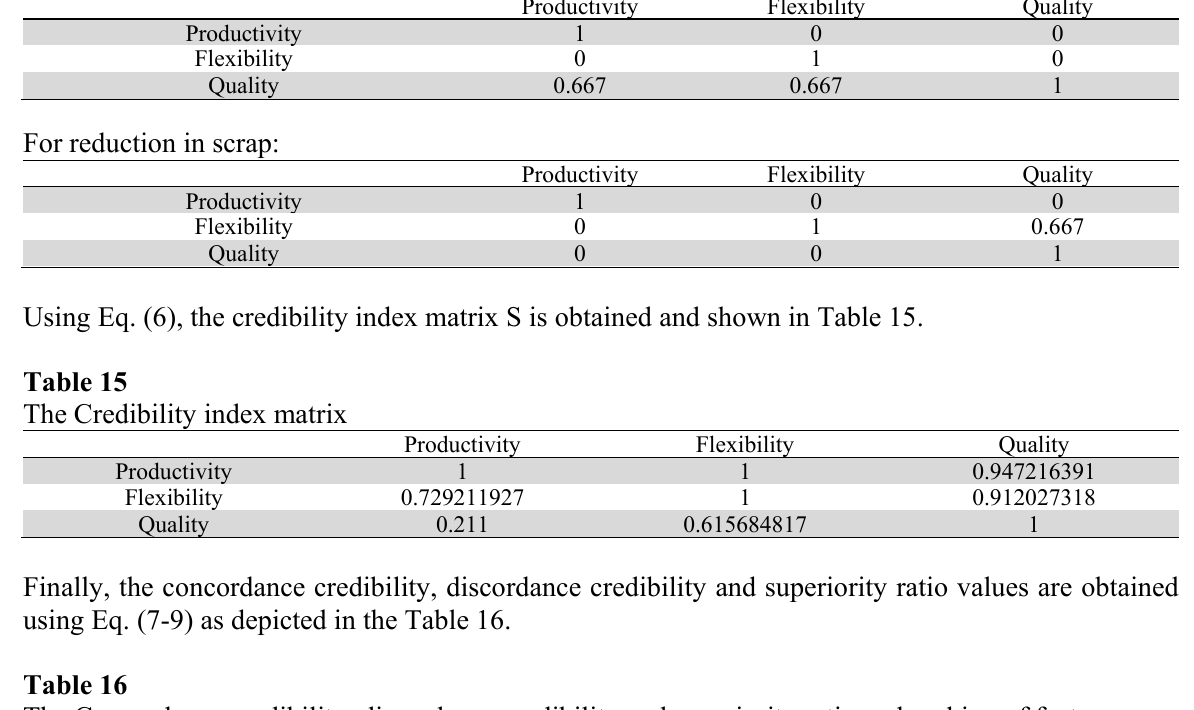
The Concordance credibility, discordance credibility and superiority ratio and ranking of factors Factors concordance credibility Discordance credibility superiority ratio Productivity